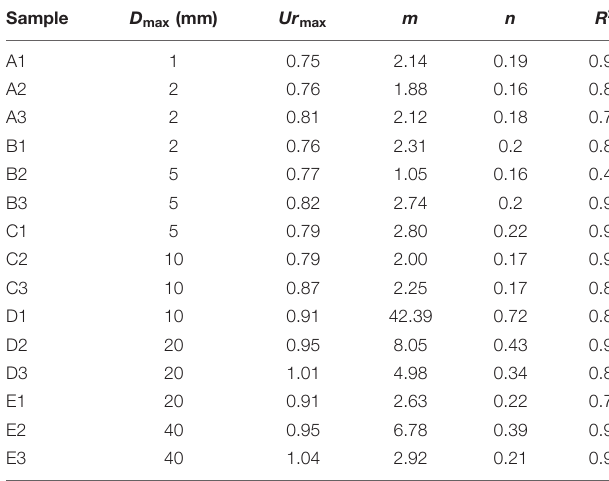
TABLE 5 | Ur max , D max , and decaying index of